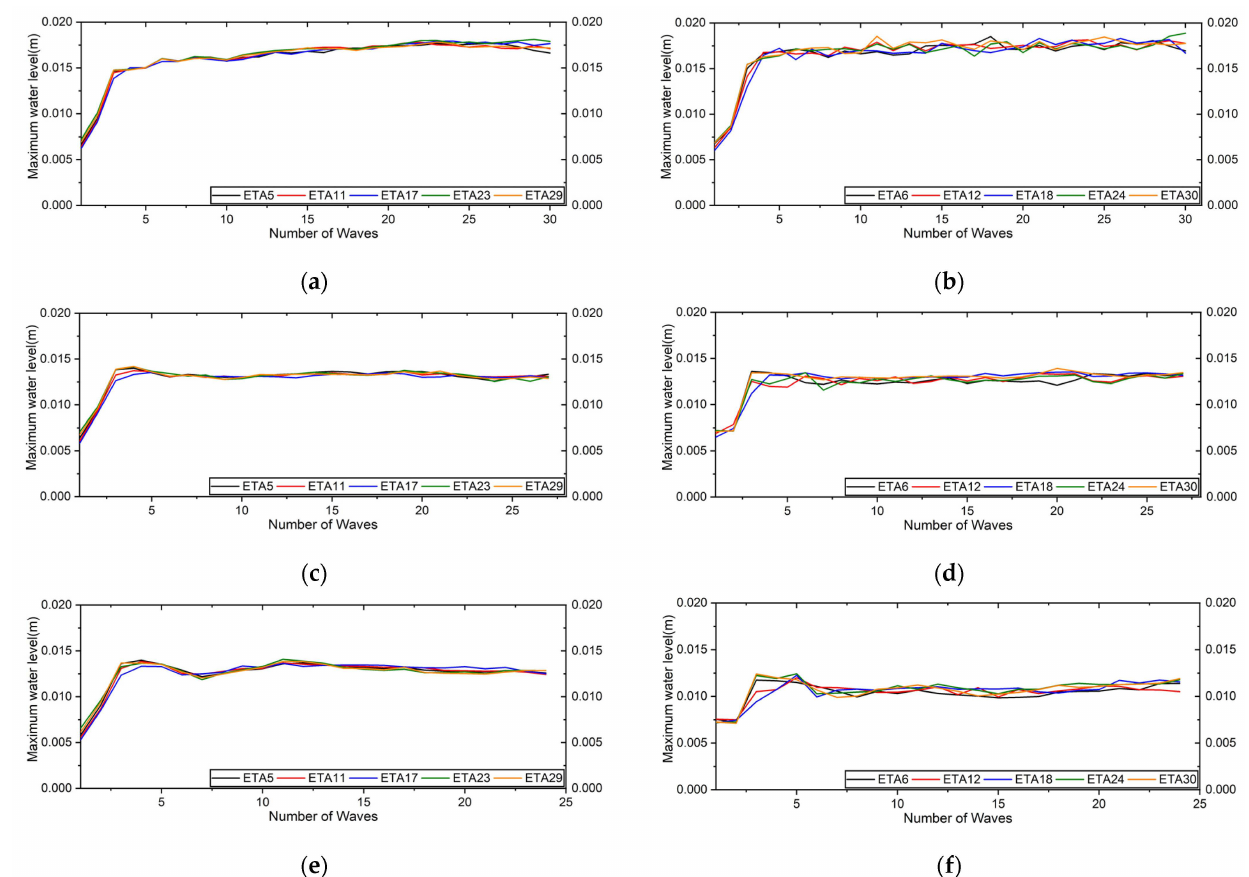
Figure 10. Variation in maximum water levels for same radial distances ( r = 369 cm and r = 405 cm ) at five different cross-sections in ( a , b ) case 1 (T-1.80 s), ( c , d ) case 2 (T-2.0 s), and ( e , f ) case 3 (T-2.25